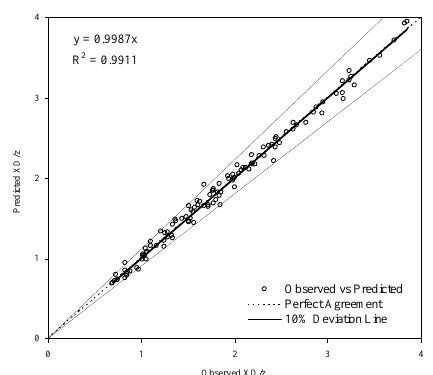
Figure 6. Comparison between observed and predicted equation (14) to estimate XD/z .